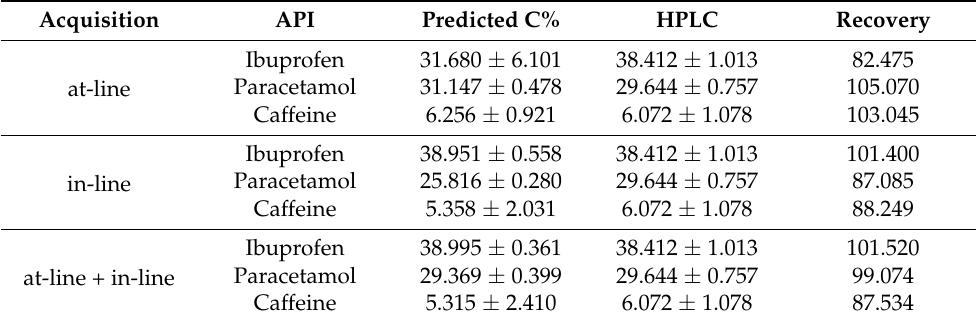
Figure 4. Predicted concentrations of ibuprofen ( a ), paracetamol ( b ) and caffeine ( c ) in function of number of rotations. Blue line: at ‐ line model; red line: in ‐ line model; green line: at ‐ line+ in ‐ line model; dotted black line: target concentration confirmed by HPLC. Table 4. Recovery of predicted API content against reference